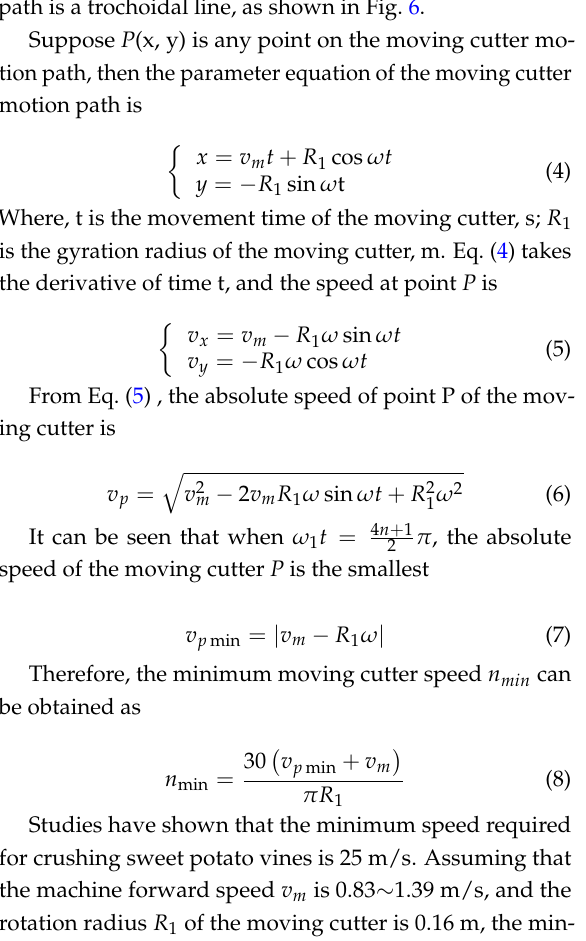
1.Fixed cutter 2. Fixed cutter handle Fig. 5. Fixed cutter structure